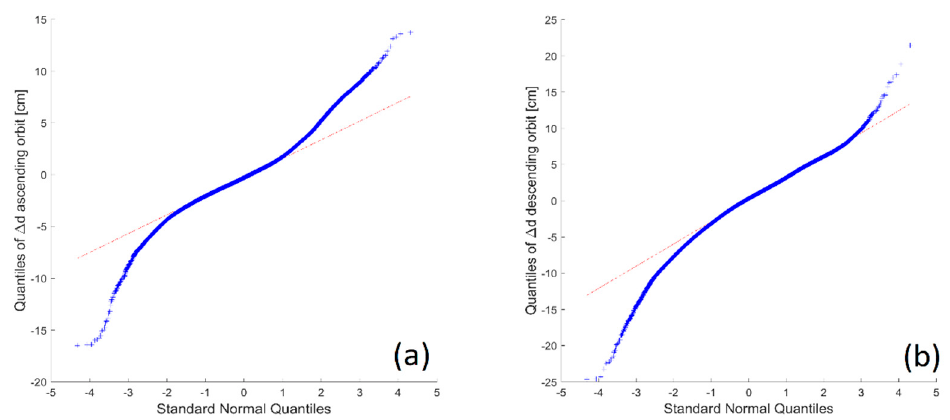
Figure 10. Quantile–quantile plot of ∆ d residual deformations for ascending orbit ( a ) and descending orbit ( b ) compared with the normal distribution.